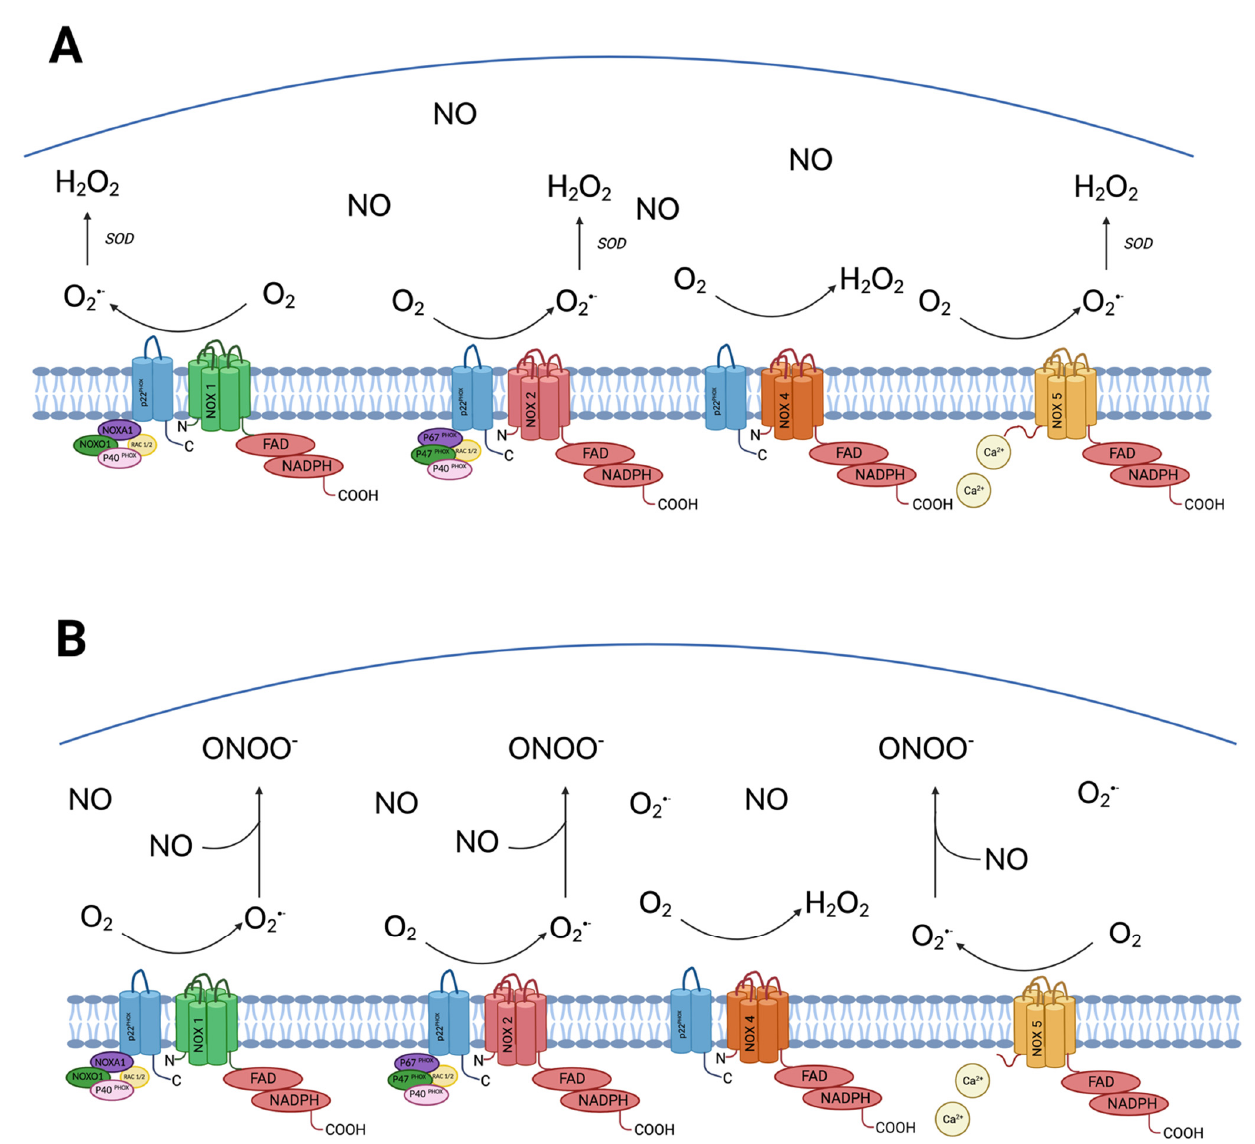
Figure 1. Panel ( A ) Structure and function of Nox1–5 isoforms of NADPH oxidase and their function in health: Nox1–5 all contain a catalytic six transmembrane domain protein complex, the N-terminal transmembrane domain of this protein complex binds two heme groups, and the C-terminal domain binds to FAD which in turn binds with NADPH to form the NADPH oxidase complex. All Nox isoforms (except Nox5) are reliant on p22phox, a membrane anchored subunit for their activity. Differences exist amongst the regulatory cytosolic subunits required for each Nox isoform. Nox1 requires activation of regulatory subunits NOXA1, NOXO1, p40phox and Rac whilst Nox2 (also called gp91phox) requires